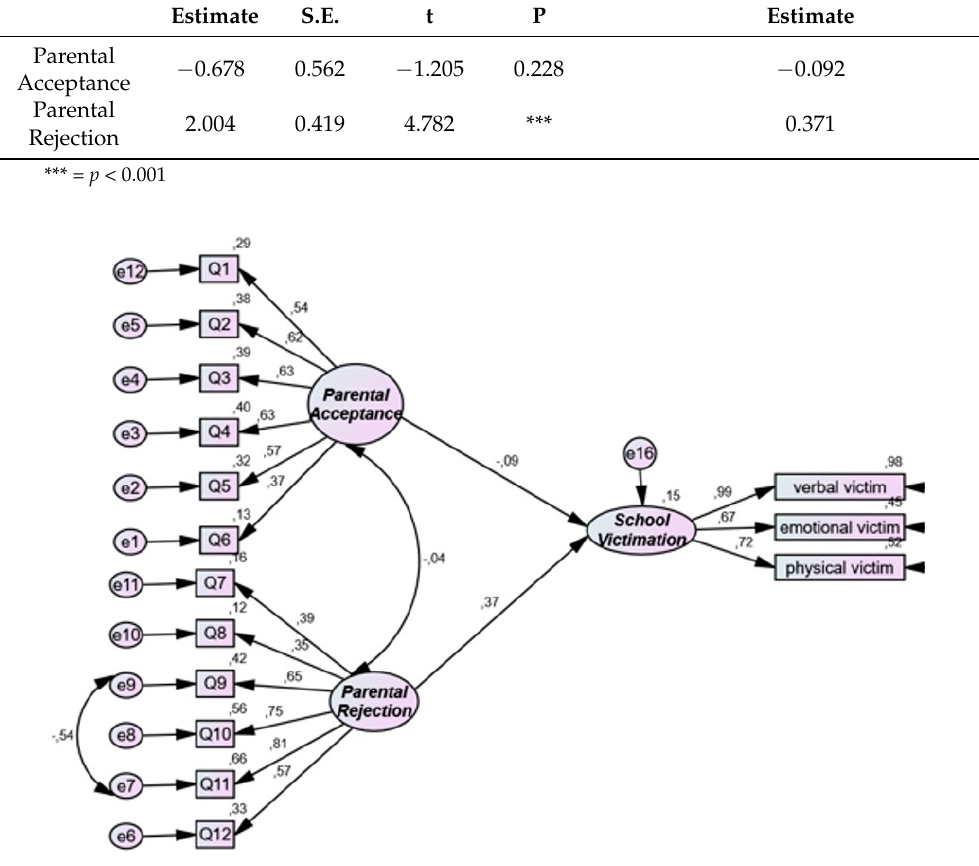
Figure 3. Structural model for research question 3. Note the structural equation modeling links between parental acceptance and rejection as an independent variable and school victimization as a dependent variable.